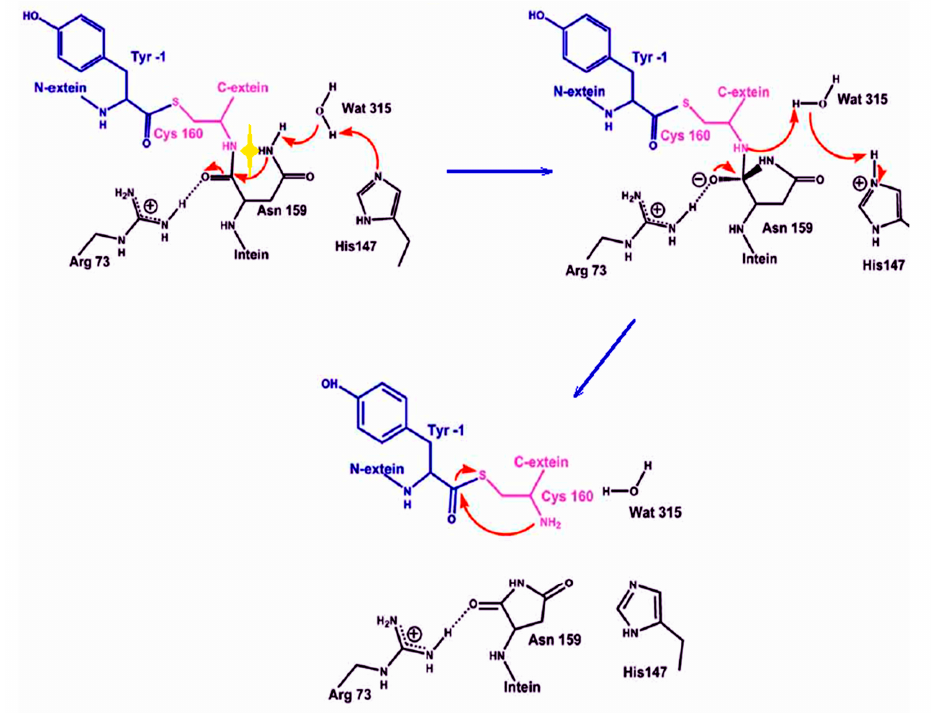
Figure 10. A part of the proposed intein SspDnaE splicing mechanism involving the Asn159 nucleophilic attack (marked with the yellow star) at the nearby amide bond carbonyl. Reprinted from [45] with permission from Elsevier.